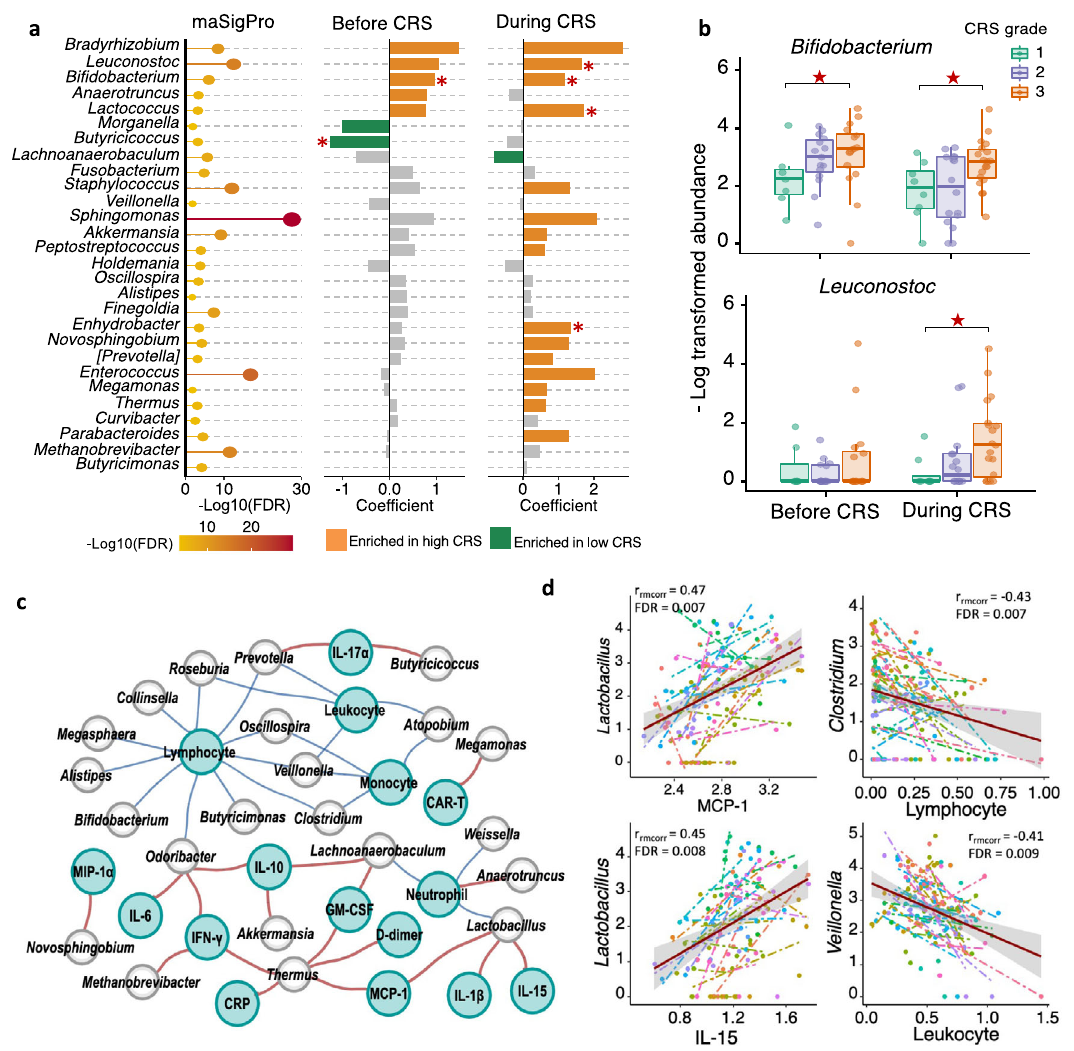
Fig. 5 | Compositional differences between subjects with different CRS grades in MM patients. a Correlation of differentially abundant genera with CRSgrade. Bubble plot in the left shows signi fi cant genera between severe and mild CRS groups by maSigPro ( n =27). Bar plots in the middle and right show signi fi cances and coef fi cients by generalized linear-mixed models (GLMMs) before and during CRS. Orange bars indicate positive correlation with CRS. Green bars indicate negative correlation. Red stars marked genera that was identi fi ed to be differen- tiallyabundantbylineardiscriminantanalysis( p <0.05forKruskal-WallisHstatistic and LDAscore>2). P values by lineardiscriminantanalysisfor Bi fi dobacteriumand ButyricicoccusbeforeCAR-Twere0.003and0.027,respectively; P valuesbylinear discriminant analysis for Leuconostoc, Bi fi dobacterium, Lactococcus, and Enhy- drobacter after CAR-T were 0.016, 0.029, 0.0029, and 0.037, respectively. b Mean bacterial abundance in MM patients with different CRS grades before and during occurrenceofCRS( n =43).Redstarsindicatesigni fi cantdifferencebetweenGrade 1 CRS and Grade 3 CRS group by all three methods in panel a . P values for Bi fi do- bacteriumbymaSigProwas8.9e-08,bygeneralizedlinear-mixedmodelwere9.75e-